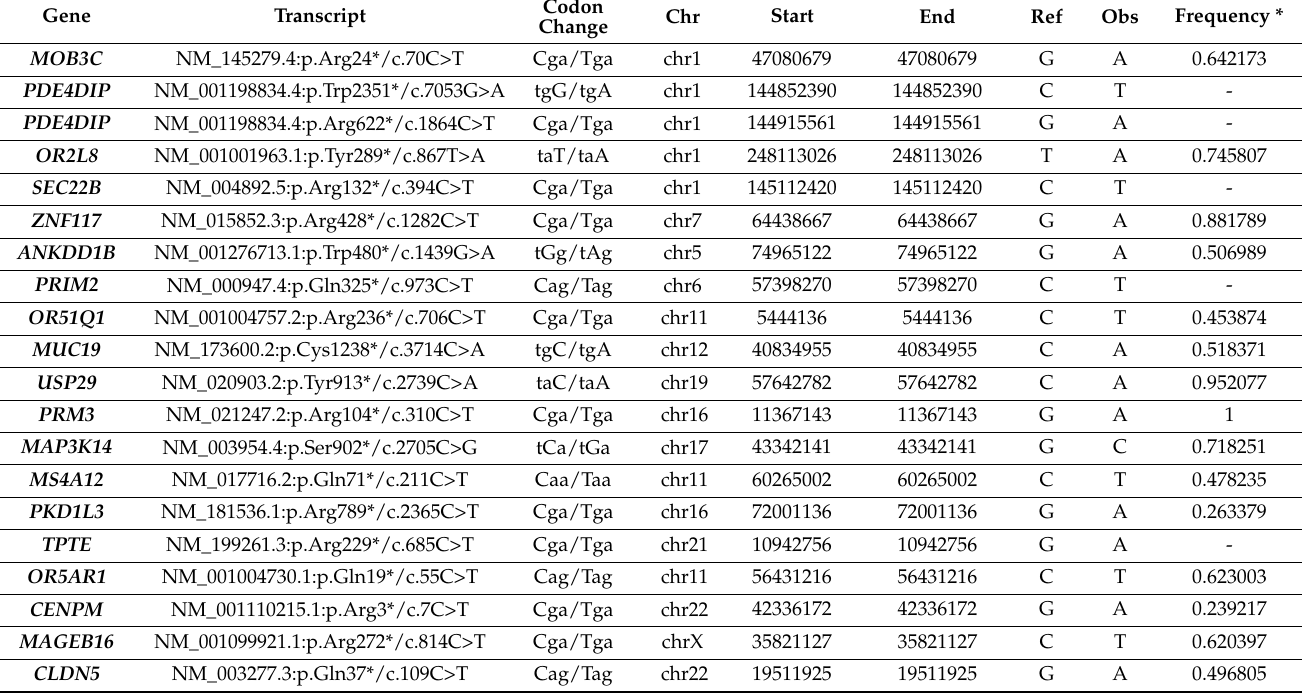
Table 2. Nonsense mutations identified in the seven whole-genome samples.